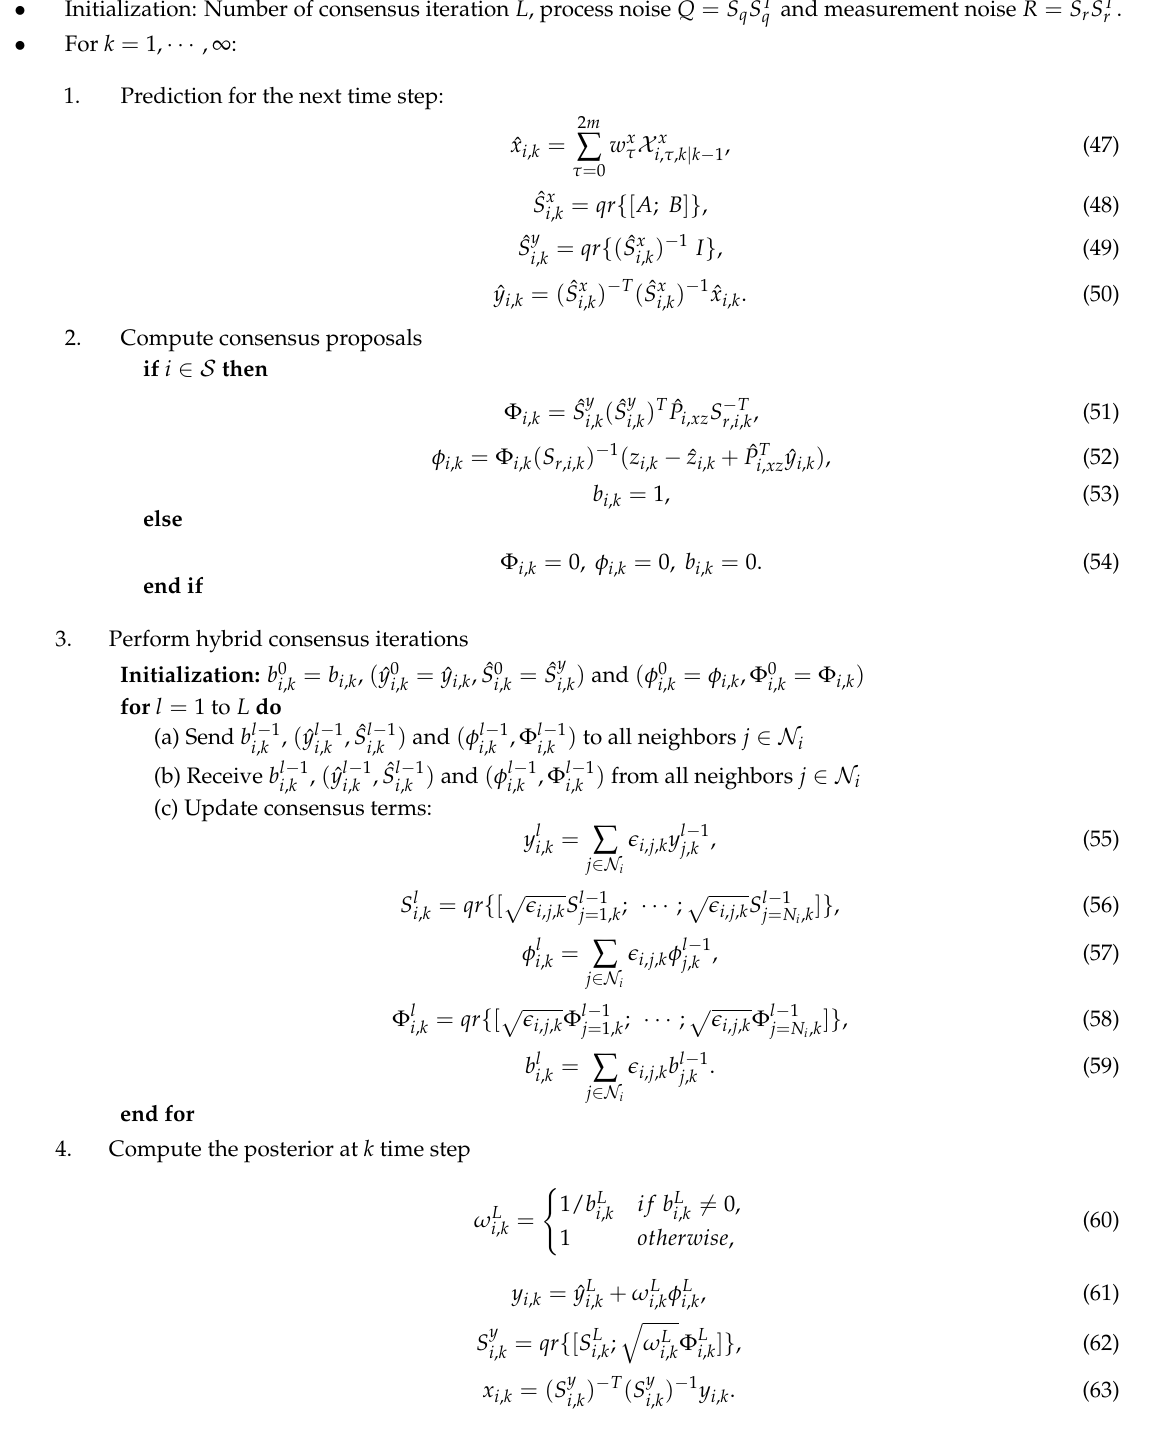
Algorithm 3 Square-Root Central Difference Dynamic Hybrid Consensus Filter